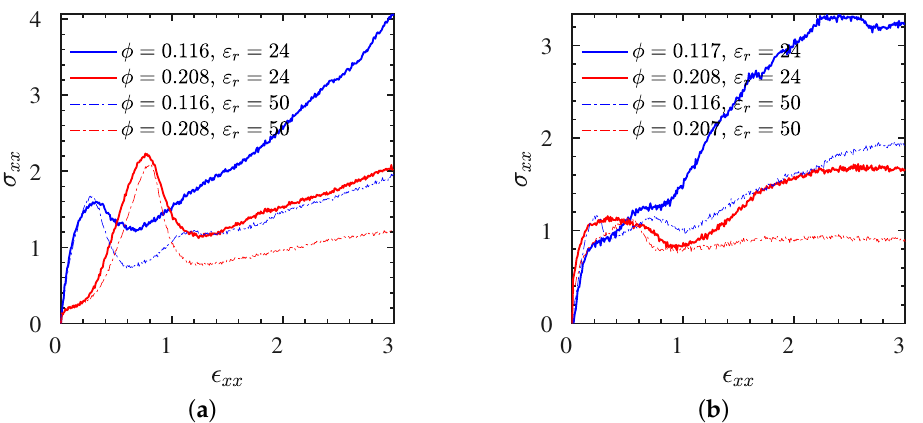
Figure 4. All eight L and S systems at identical engineering strain rate. Stress–strain curves for ( a ) L ( N = 200), and ( b ) S ( N = 40) systems at different NP loadings and dielectric constants subjected to a stretching rate of ˙ (cid:101) xx =